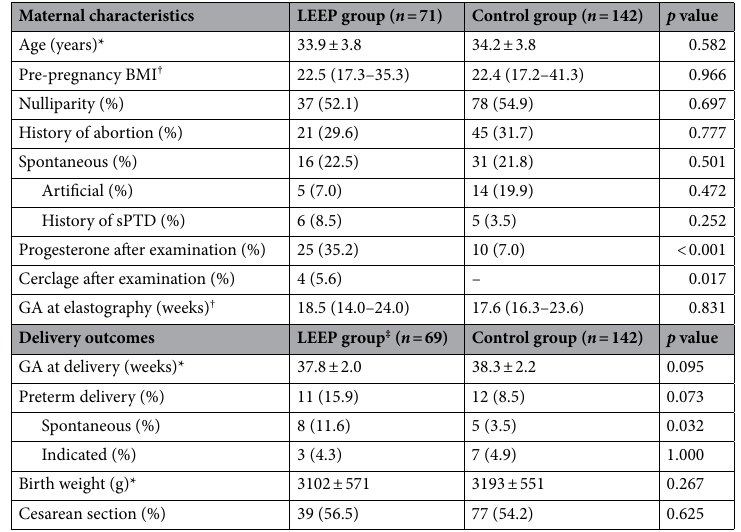
Table 1. Maternal characteristics and delivery outcomes of the LEEP group versus the control group. *Mean ± standard deviation; † median (range); ‡ excludes two cases of follow-up loss. BMI body mass index, GA